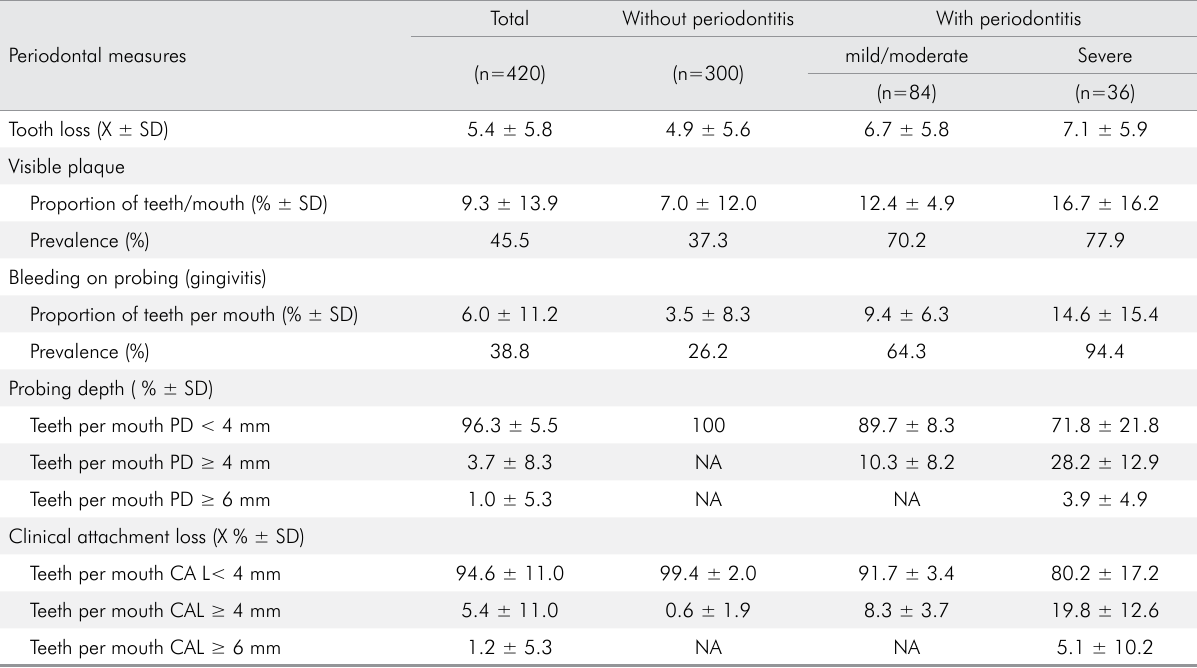
Table 2. Periodontal clinical parameters according to the presence of periodontitis. Advento study. Sao Paulo. 2016. Periodontal measures